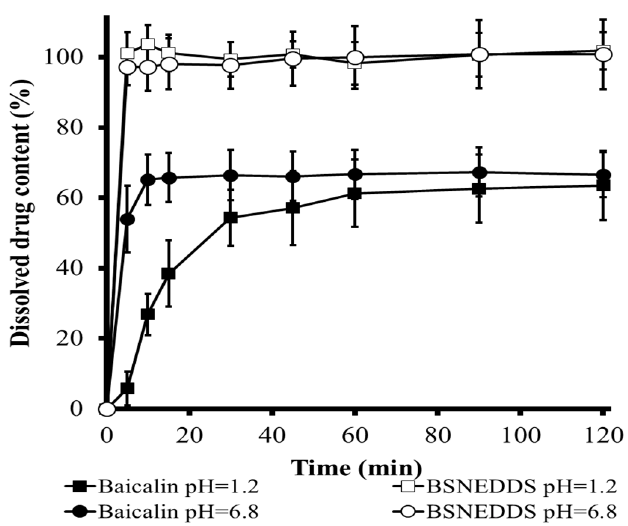
Figure 7. Dissolution profiles comparison of baicalin powder (filled symbol) and baicalin in optimized liquid SNEDDS (empty symbol) formulations at pH = 1.2 (square) and pH = 6.8 (circle). (Mean ± SD; n = 3).